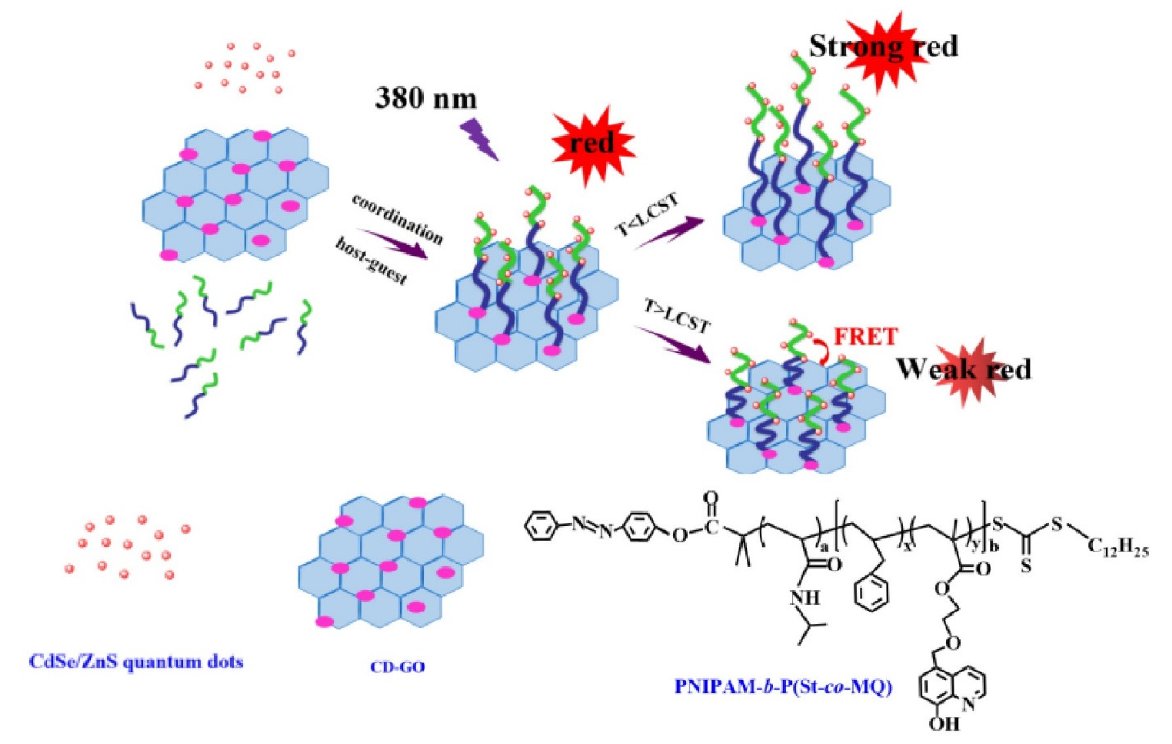
Figure 2. Schematic illustration of the preparation of QDs/polymer/GO and its thermo-response be- havior.